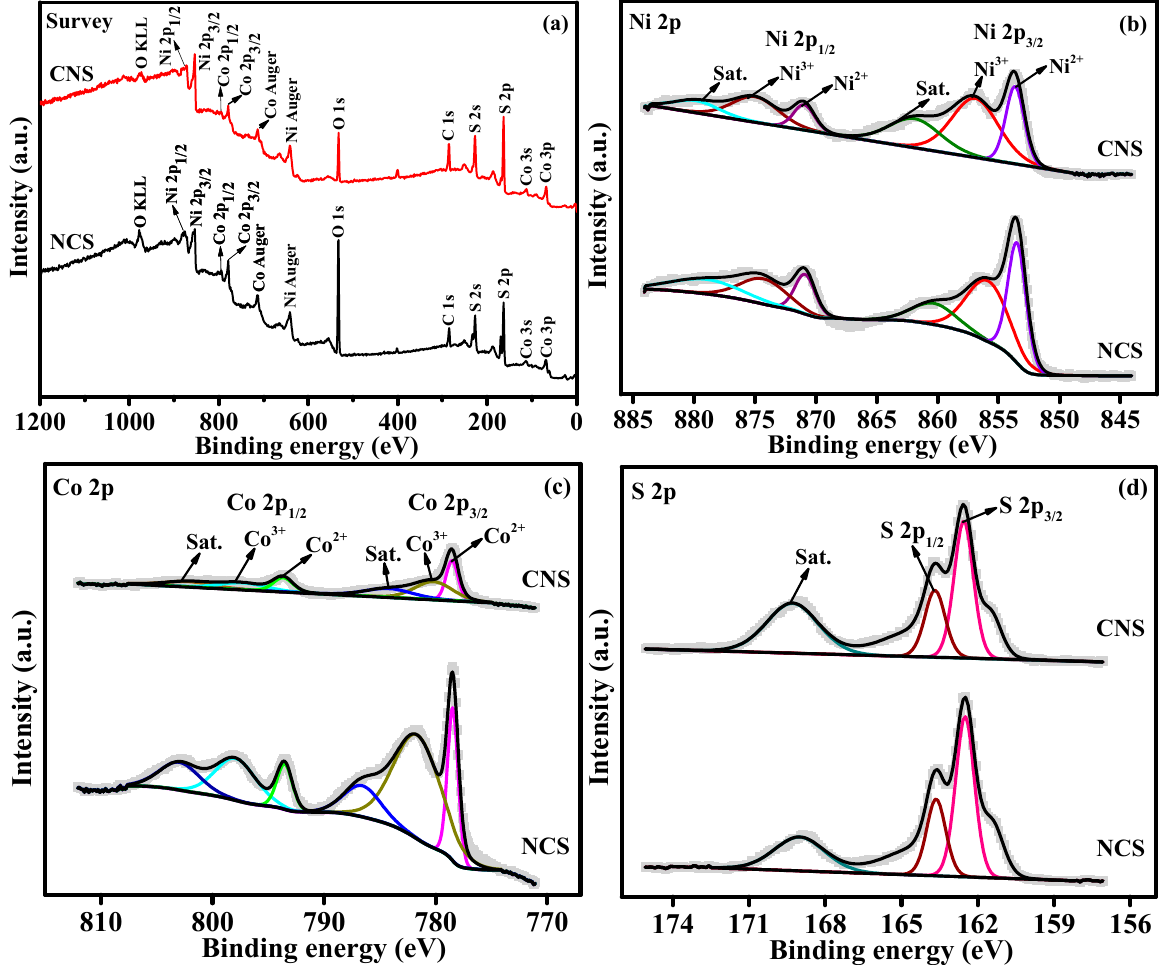
Figure 2. ( a ) The XPS survey scan spectrum of NCS and CNS samples. The deconvoluted spectra of ( b ) Ni 2p, ( c ) Co 2p, and ( d ) S 2p. The morphological, structural features, and elemental composition of the as-synthesized NCS and CNS samples were studied by field-emission scanning electron microscopy (FE-SEM), field-emission transmission electron microscopy (FE-TEM), high resolution TEM (HRTEM), selected-area electron diffraction (SAED), and energy dispersive